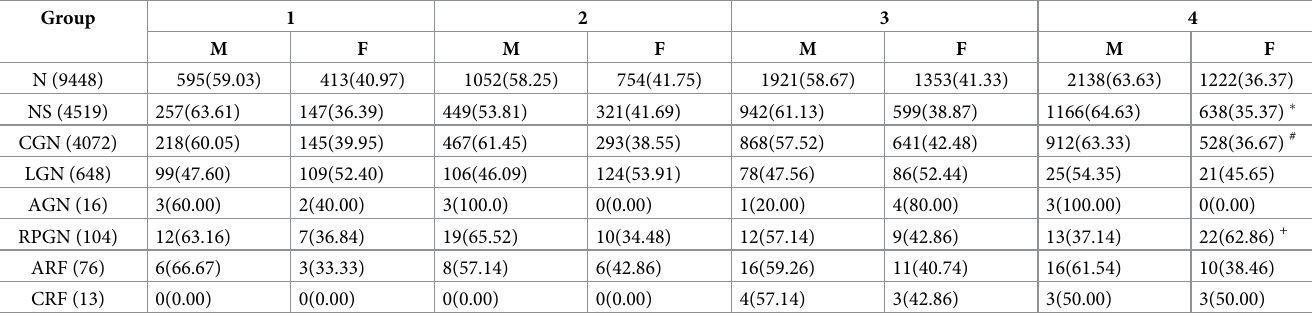
Table 4. Comparison of clinical manifestations of different genders in each